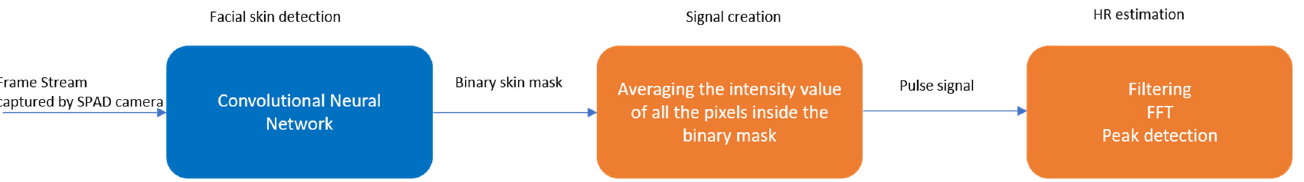
Figure 5. rPPG using SPAD camera.